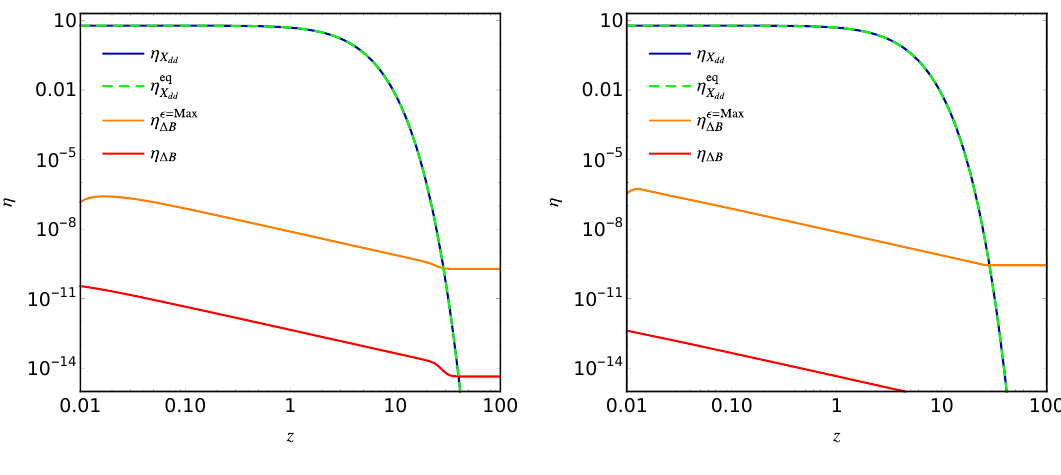
Figure 18 . Low-scale scenario. Evolution of baryon asymmetry η ∆ B (red lines) for the maximal value of (cid:15) with respect to z = m couplings are chosen as follows: Left: f solid line indicates the baryon asymmetry for (cid:15) = 2 r , and the red solid line assumes (cid:15) ≈ 3 . 6 × 10 − 3 ( left ) and (cid:15) ≈ 3 . 6 × 10 − 5 ( right ) as given by eq. 5.1 with x = 0 . 2 . Blue solid and green dashed lines depict the number density and equilibrium number density of X number density),